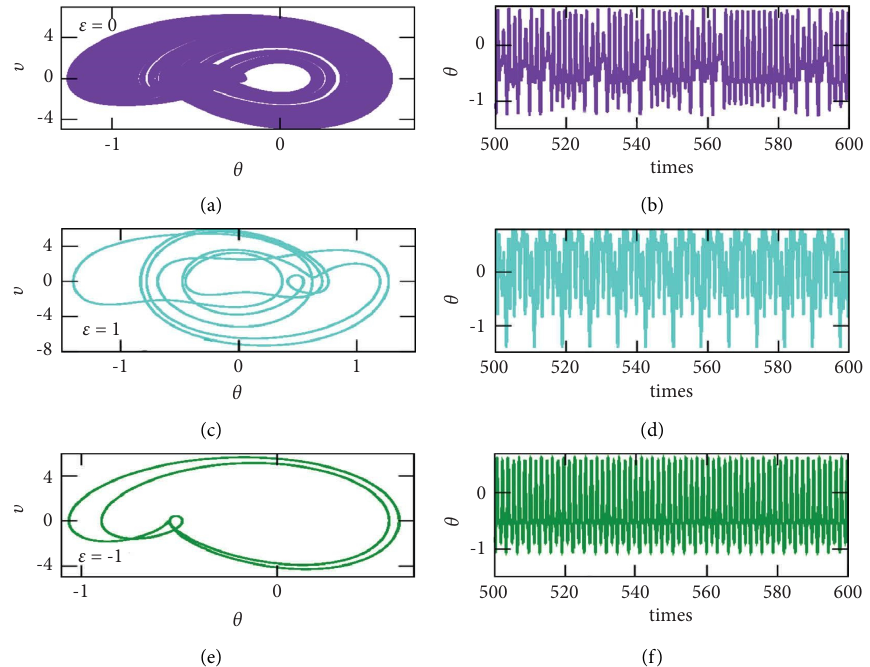
Figure 6: Phase portrait and its corresponding time series for ϵ � 0 ; ± 1 ; α � 10 ; β � 1 ; Ω � 2 ; C 10 ; U � 2 . 5 ; F �